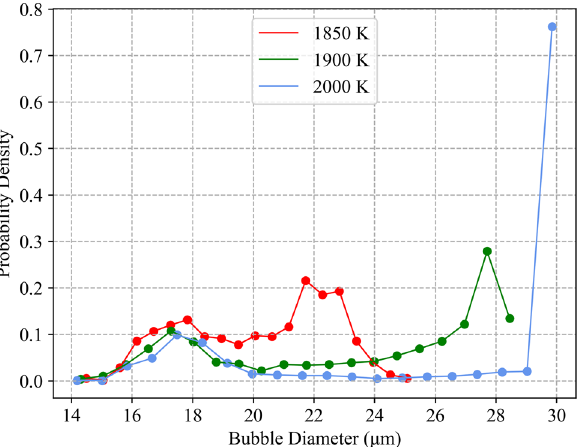
Figure 8. Plot of bubble diameter against probability density of the particle CF-01-R009, with radius 406.5 μm, at initial temperatures of 1850 K, 1900 K and 2000 K. The lower temperature corresponds to region A, where central bubbles experience minimal growth. The distribution at 1900 K displays the bi-modal distribution within the accepted model range for comparison. The highest temperature demonstrates the distribution above the predicted temperature range. In this case, most bubbles, including surface level bubbles, are able to reach a maximum size since the initial temperature is too high for quench-like cooling to occur.